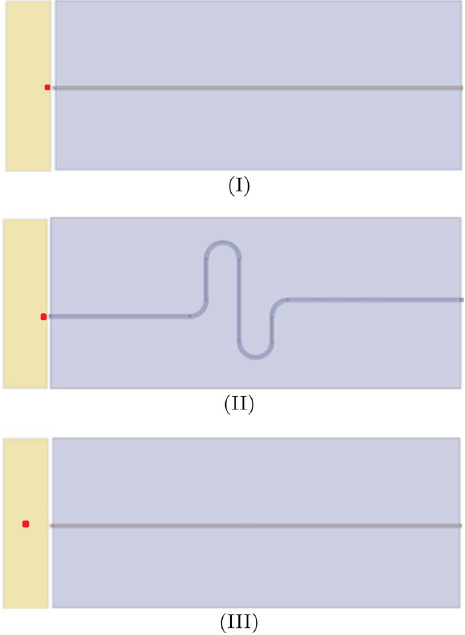
Figure 6. Geometries and position of the tube installed in the segments. The red dot indicates the tube position.